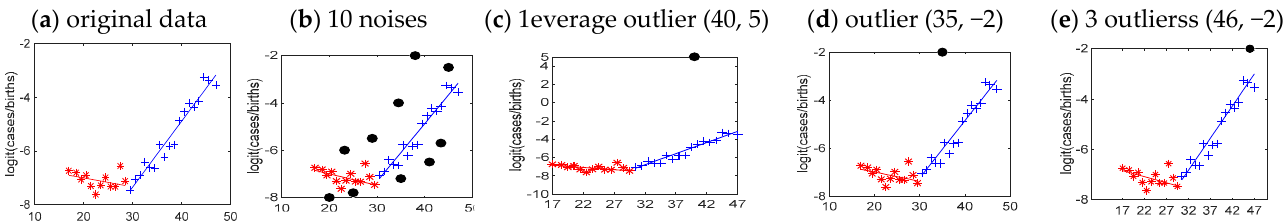
Figure 5. Plots of the estimated models for DS data with different kinds of additional outliers.